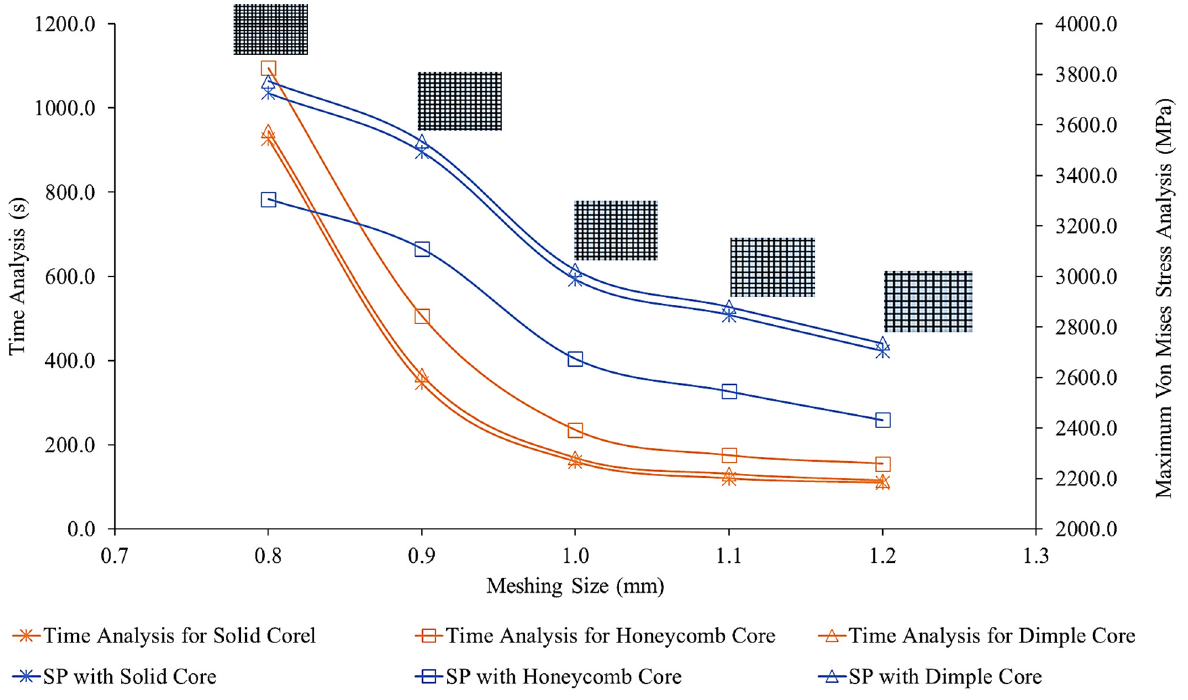
Figure 5. The mesh sensitivity analysis for meshing sizes between 0.8 to 1.2 mm, with different core designs shown for comparison. Table 2. The total number of nodes and elements for the geometrical three-dimensional sandwich panel models with different core configurations.